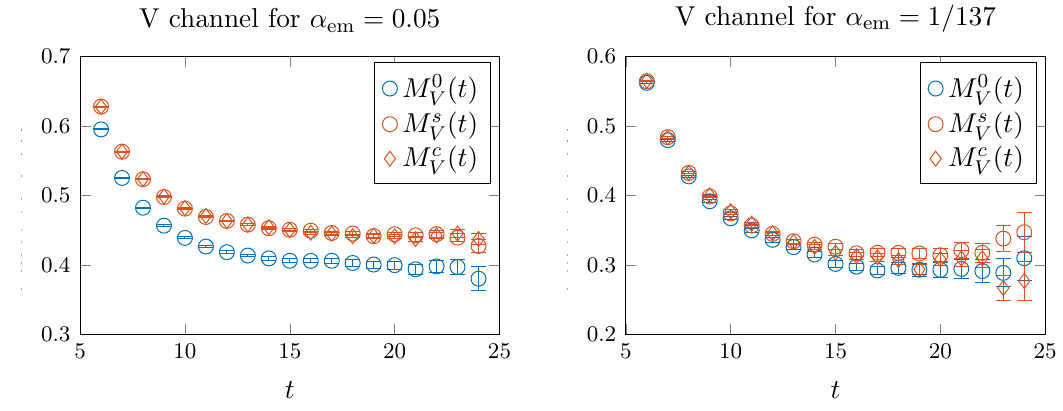
Figure 2 . Effective masses for the vector correlators at α em = 0 . 05 (left plot) and α em = 1 / 137 (right plot). In both plots the blue points correspond to the neutral states, M 0 points correspond to the charged states interpolated by using either the string, M s Coulomb, M c ( t ), operators. Also in this channel the quality of the numerical signal is essentially V the same for charged and neutral states. With these unphysical values of the bare parameters the charged-neutral mass splitting can be extracted with statistical significance at α em = 0 . 05 while more statistics is required at α em = 1 / 137. This is not surprising as vector correlators have a worse signal-to-noise ratio with respect to pseudoscalar